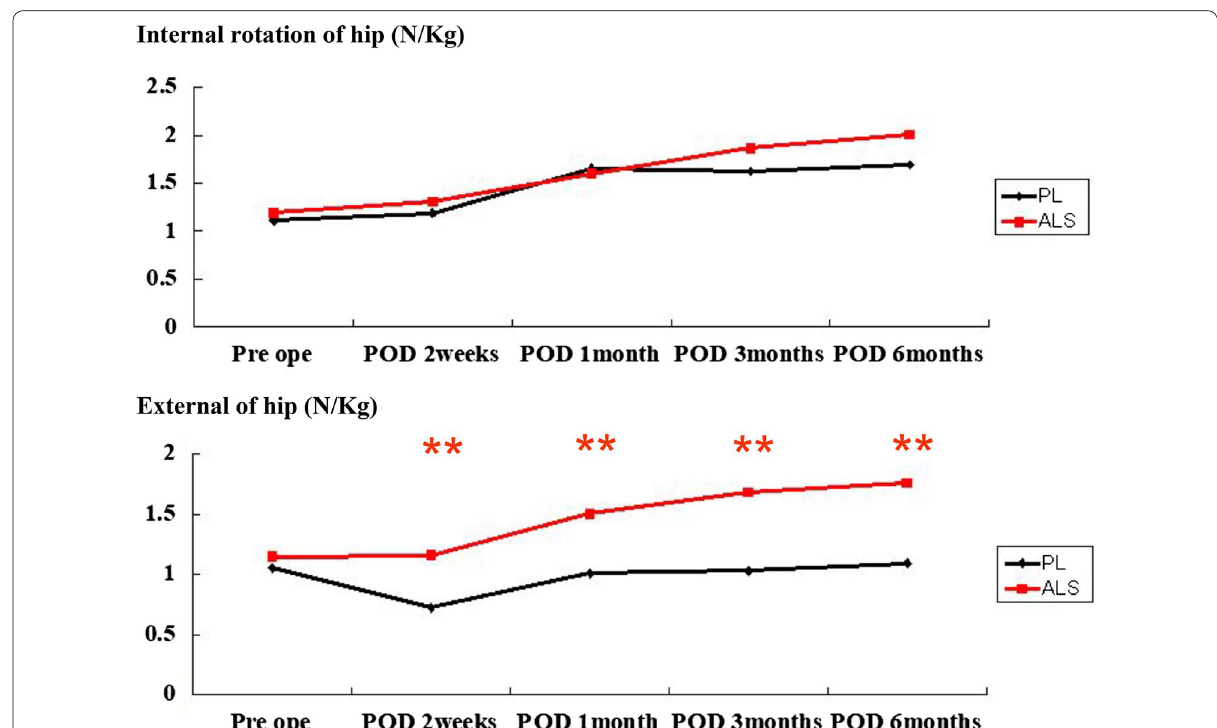
Fig. 3 Evaluation of muscle strength of hip internal and external rotation. From 2 weeks to 6 months postoperatively, hip external rotation strength was significantly lower in the PL group than in the ALS group. ALS, anterolateral supine; PL, posterolateral; POD, postoperative day. **Indicates significance at P <